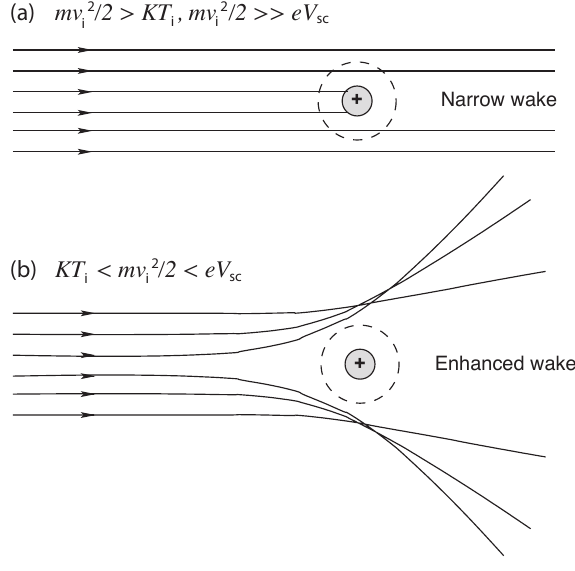
Fig. 1. Sketch of wake formation in supersonic ion flows / 2; KT e >mv 2 e / 2). (a) For ion flow energies much ( KT i <mv 2 i higher than the equivalent spacecraft potential, V sc , the wake has the typical transverse size of the spacecraft (narrow wake case). (b) For ion flow energy below V sc , ions will scatter off the positive elec- trostatic potential from the spacecraft, creating an enhanced wake. In both cases, the electrons will fill the wake, since their thermal energy is higher than the ram kinetic energy.